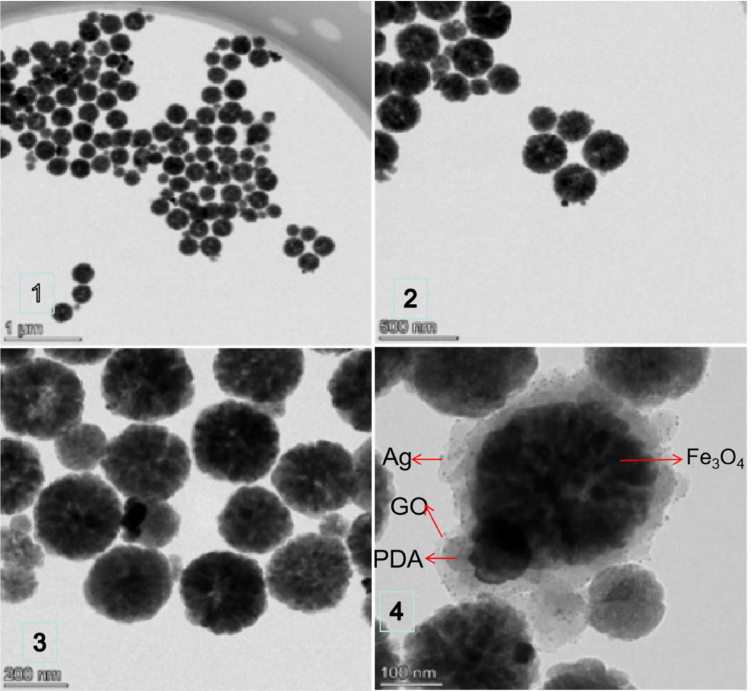
Figure 2. TEM images Fe 3 O 4 @PDA@Ag@GO of different magnifications. ( 1 ) TEM image zoomed to 1 µ m; ( 2 ) TEM image zoomed to 500 nm; ( 3 ) TEM image zoomed to 200 nm; ( 4 ) TEM image zoomed to 100